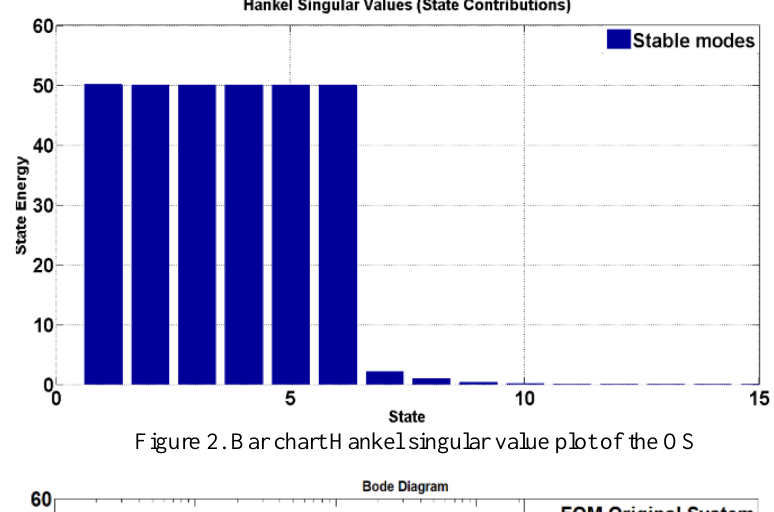
Figure 1. Time response of the OS